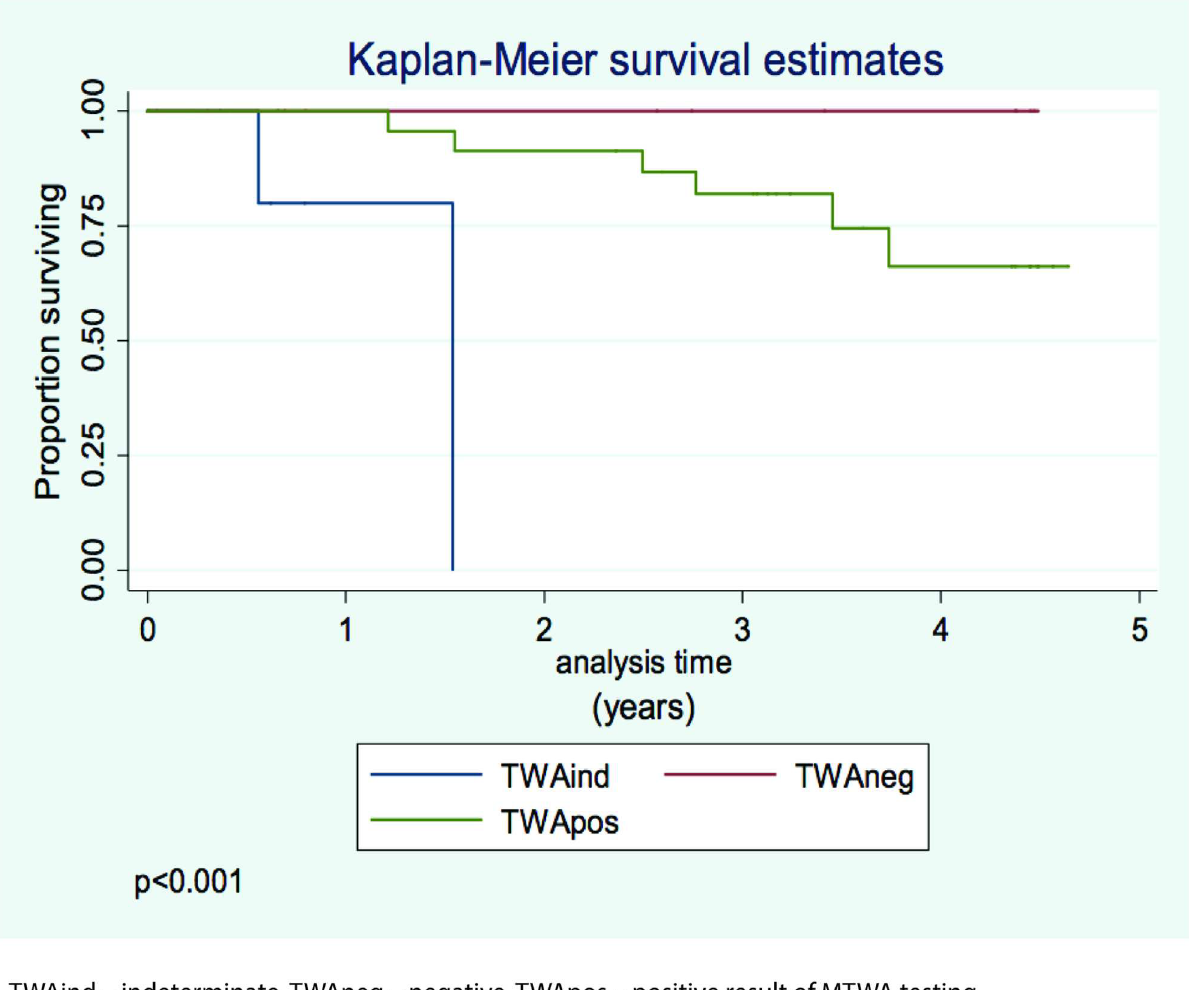
Fig 2. Survival in the study population in relation to the microvolt T-wave alternans (MTWA) testing result. TWA ind- microvolt T-wave alternans indeterminate, TWAneg-microvolt T-wave alternans negative, TWApos- microvolt T-wave alternans positive.